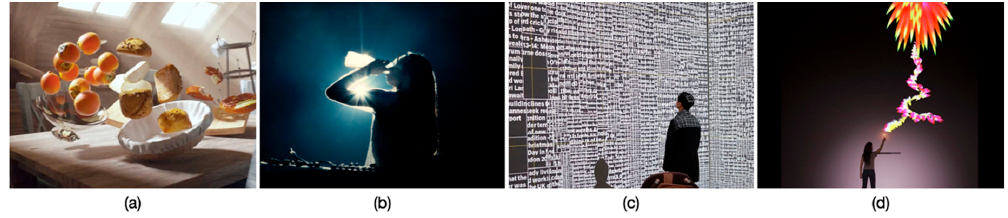
Figure 8. Examples suggested by the participants (Reprinted with permission): ( a ) flying objects video, ( b ) Seiho DJ set, ( c ) kinetic typography by LUST, and ( d ) Light my fire by Sigmasix.